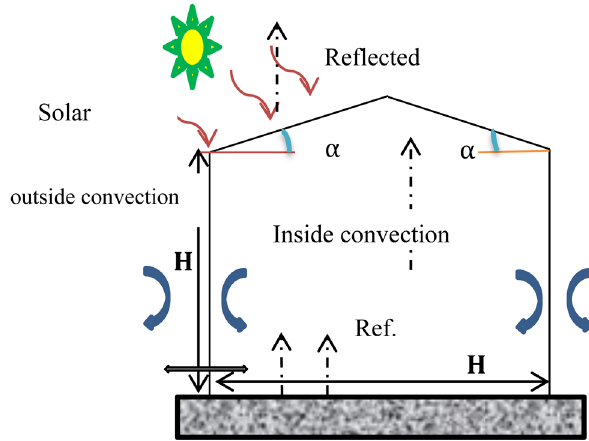
Figure 2: The greenhouse